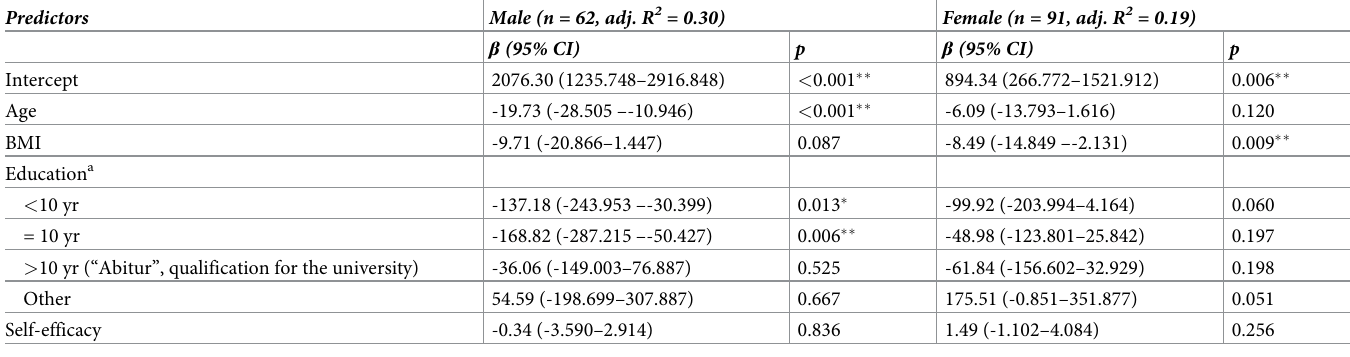
Table 6. Multiple linear regression model to identify determinants for moderate PA, separately for men and women.